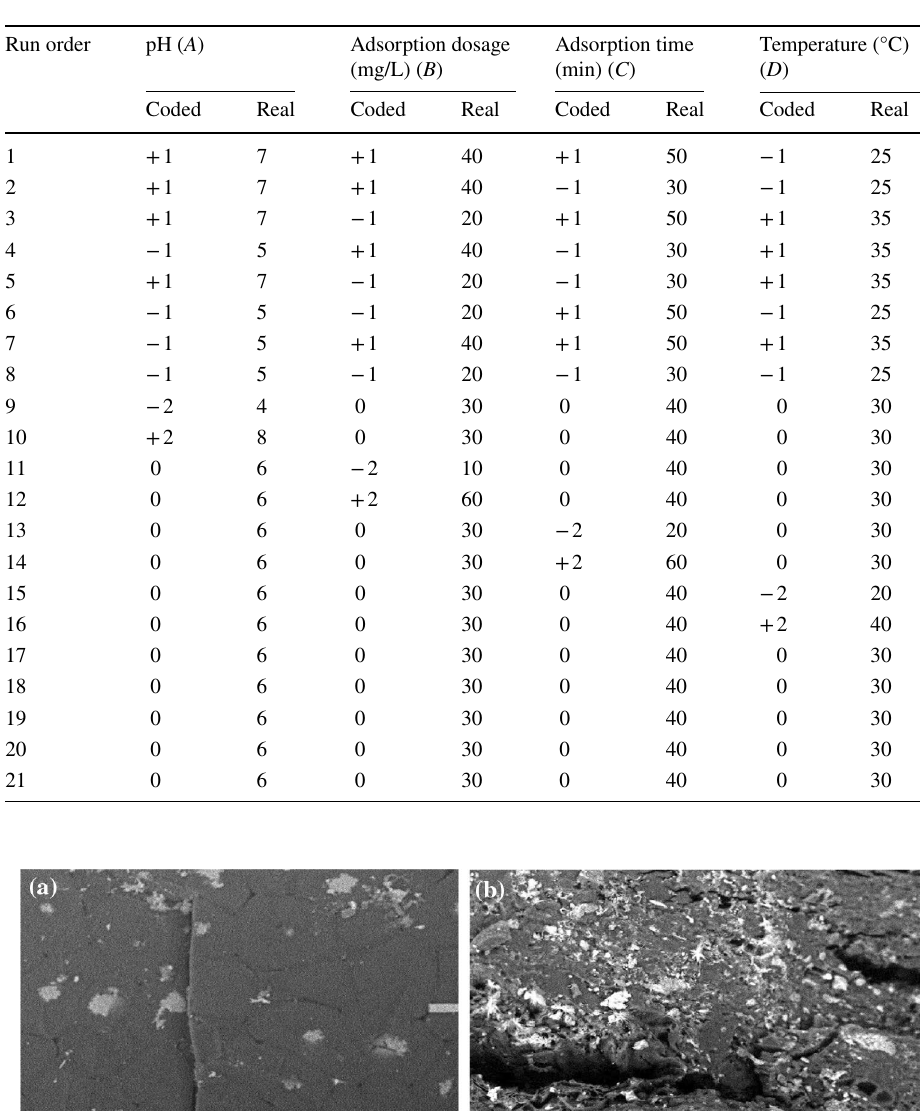
Table 2 Experimental design matrix for adsorption of fibre cement industry effluent using coal-based activated carbon